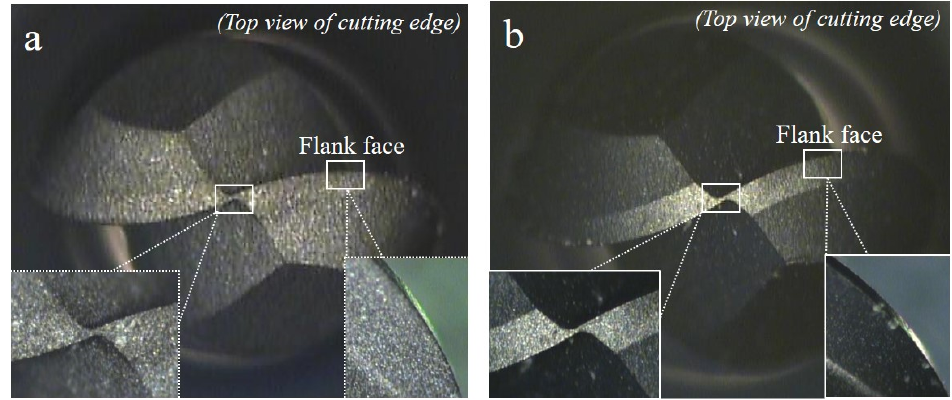
Figure 2. Optical microscope images of endmill tools with ( a ) MCD and ( b ) NCD coatings.